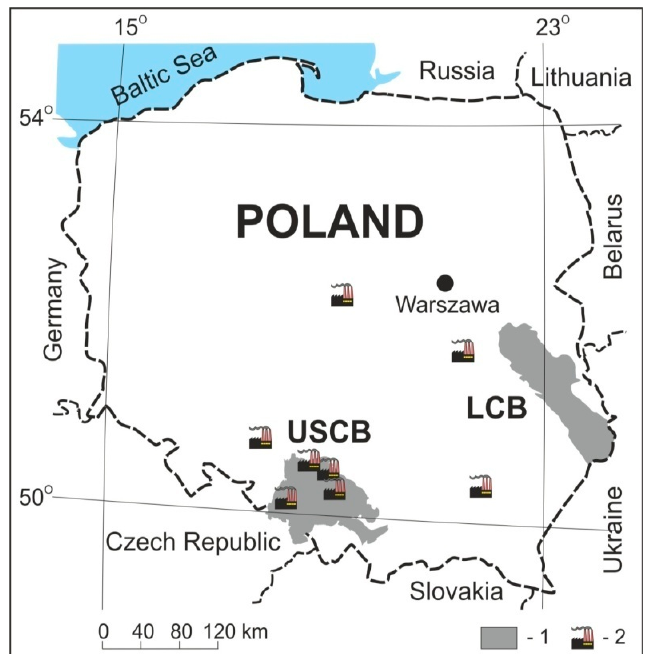
Figure 1. Location of the coal basins and thermo-electric power station in which samples were taken. 1—Area of the Lublin (LCB) and Upper Silesian Coal Basin (USCB), 2—thermo-electric power station. Table 1. Petrographical characteristics of feed coal from the Lublin (LCB) and Upper Silesian Coal Basin (USCB), and yield fraction of the feed coal, fly ash, and slag.